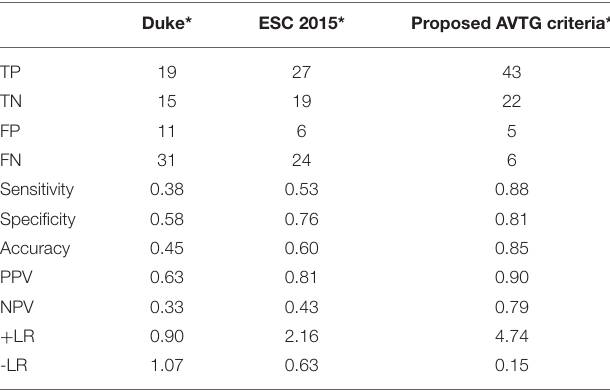
TABLE 8 | Comparative assessment of the Duke criteria, the ESC criteria, and the New Bentall 2020 criteria in 76 patients.